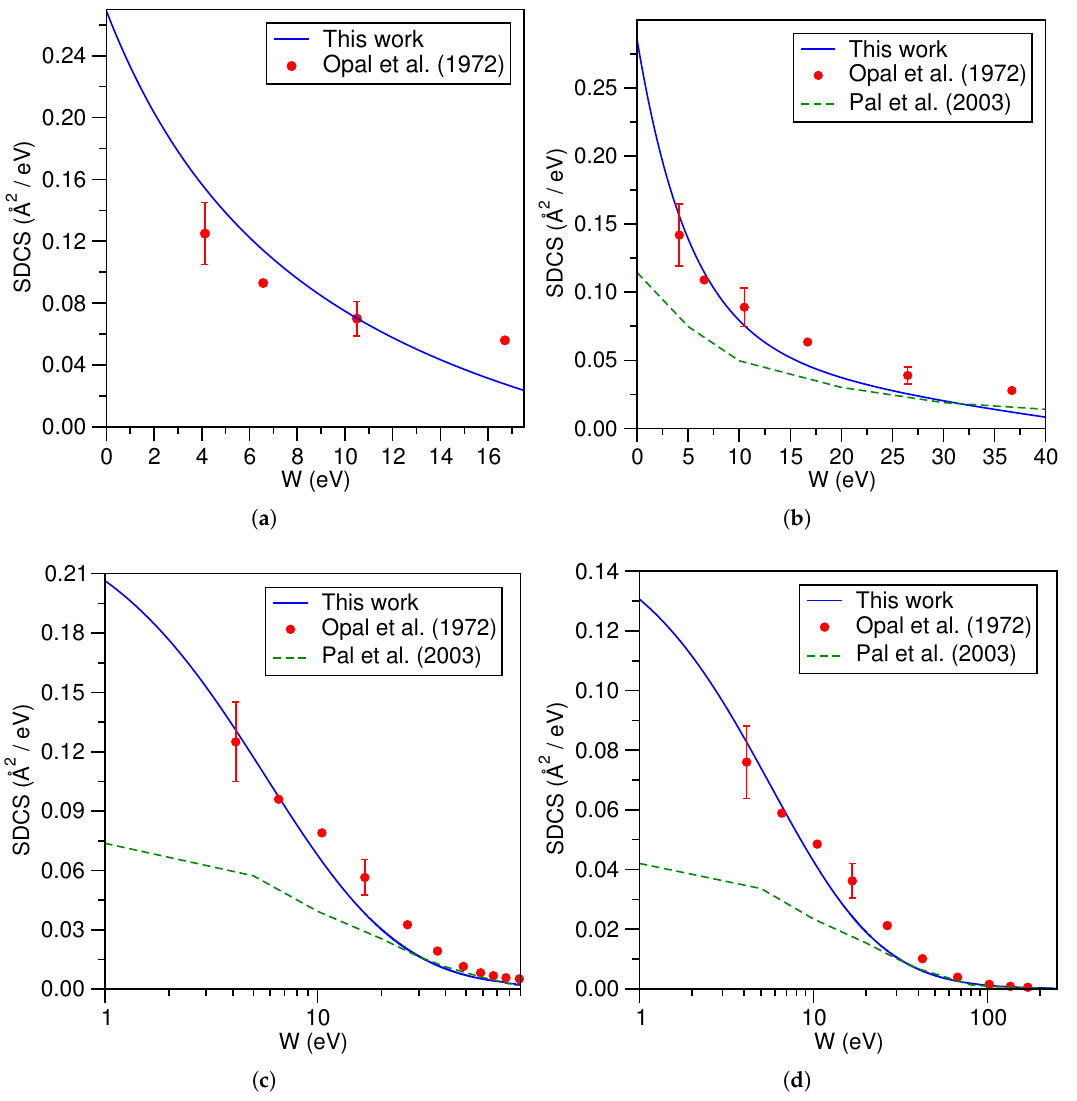
Figure 5. Electron-impact SDCS for O 2 at a primary electron energy of ( a ) T = 50 eV, ( b ) T = 100 eV, ( c ) T = 200 eV, and ( d ) T = 500 eV. The solid lines represent the present results, the dashed lines are the results of Pal et al. [39], and the filled circles are the experimental measurements of Opal et al.